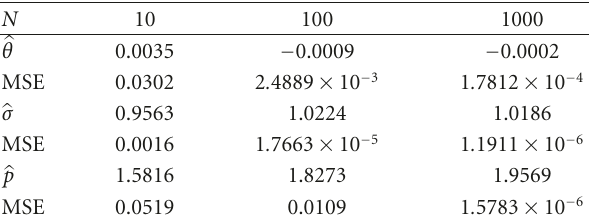
Table 1: Multiparameter Estimation Results for GCD Process with length N and ( θ , σ , p ) = (0,1,2).